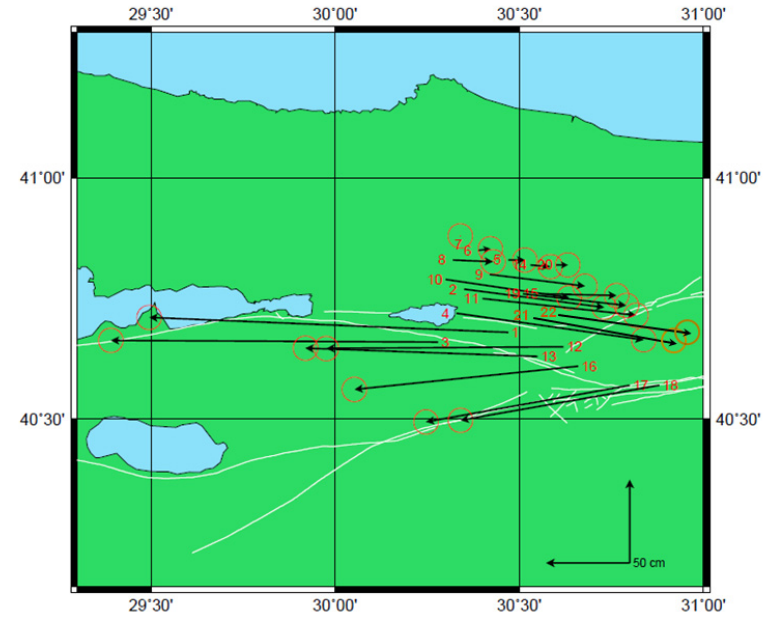
Fig. 5. Surface deformations of Sakarya geodetic control network.